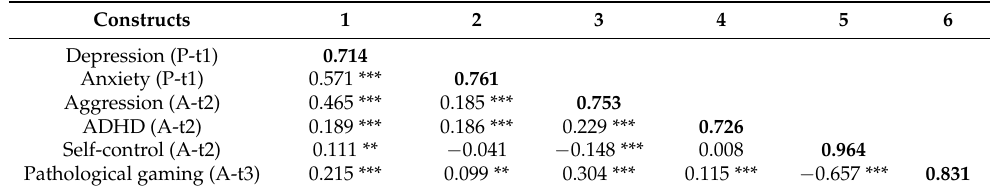
Table 2. Correlations and discriminant validity